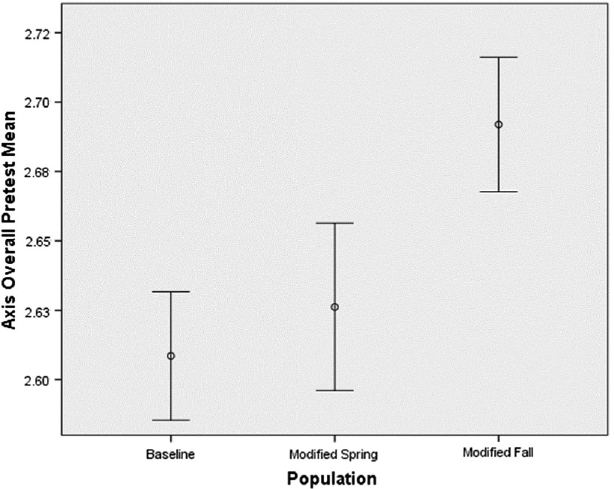
FIG. 2. Error bar plot of average pretest EBAPS score on overall axis with data